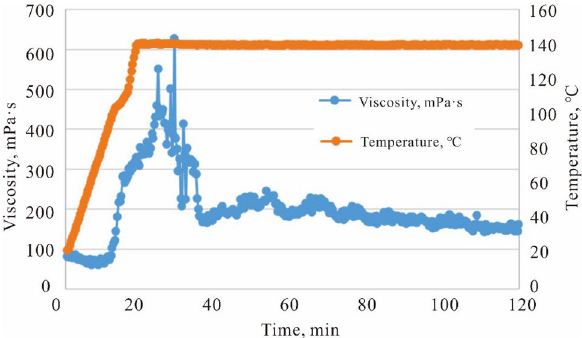
Fig. 5 Rheological profile of CaCl